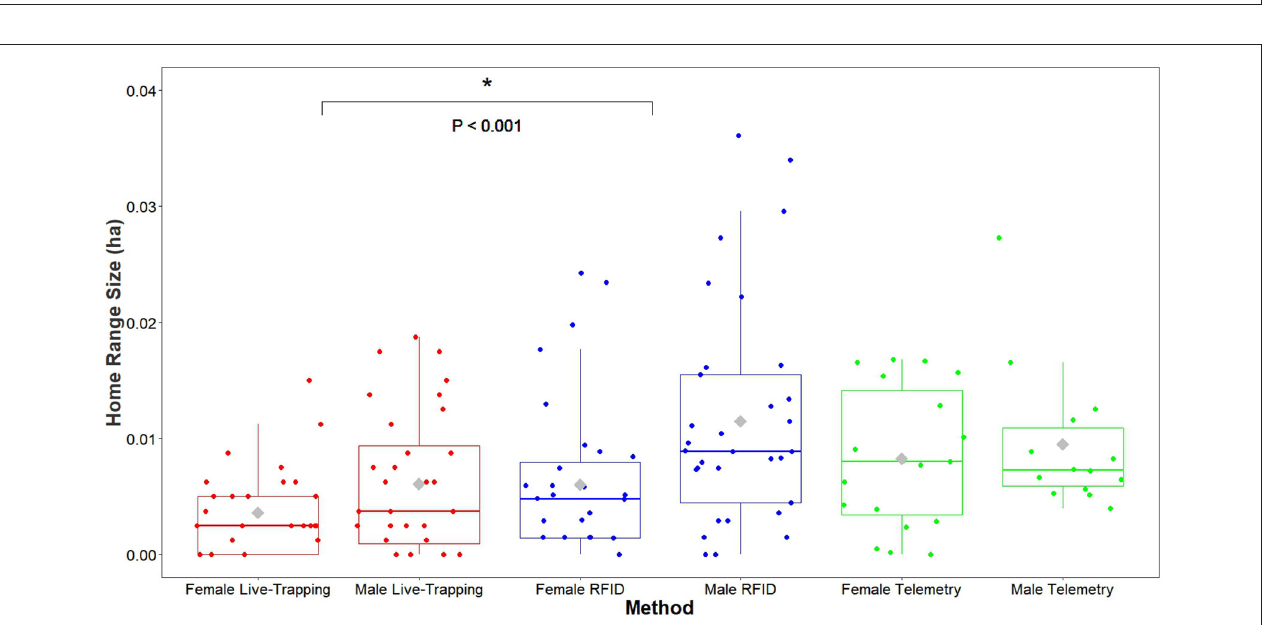
FIGURE 4 | The home range overlap between each pair of prairie voles based on the minimum convex polygon from VHF radio telemetry data and the social association index for that pair (the strength of the association) from social network analyses generated using data from the RFID system. Note that the x-axes are the same on both panels but the y-axes are different.